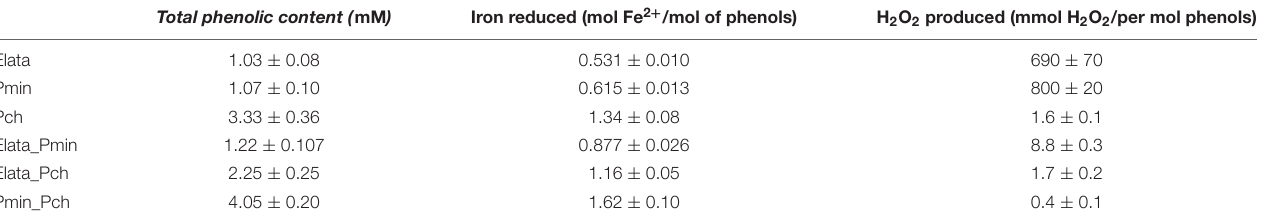
TABLE 1 | Total phenolic content (Folin–Ciocalteu) of LMW fungal extracts from the three GTD fungi, together with iron reduction (Ferrozine), and H 2 O 2 production (FOX) from those extracts.